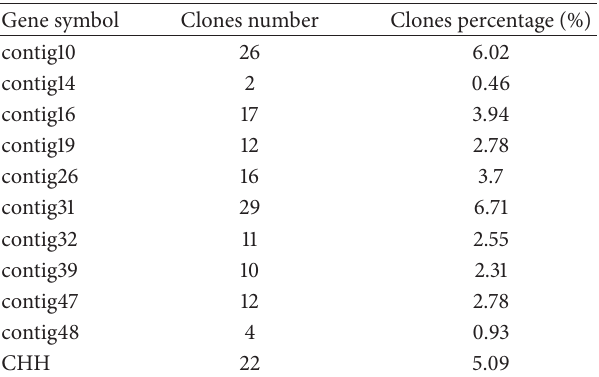
Table 3: Clones percentage of the selected contigs or gene clusters in the SSH